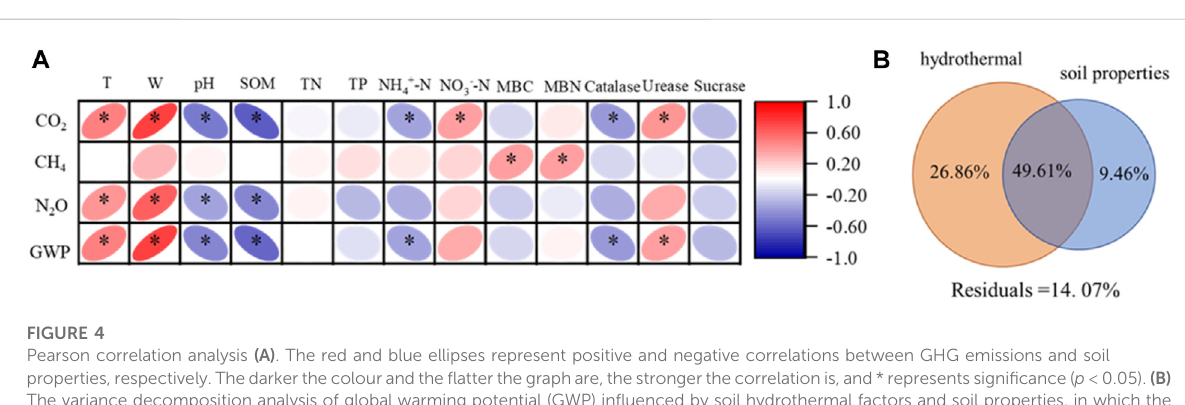
The error bars show standard errors: n = 9 and 12 for temperature and WHC, respectively. Different letters in each treatment indicate signi fi cant differences.